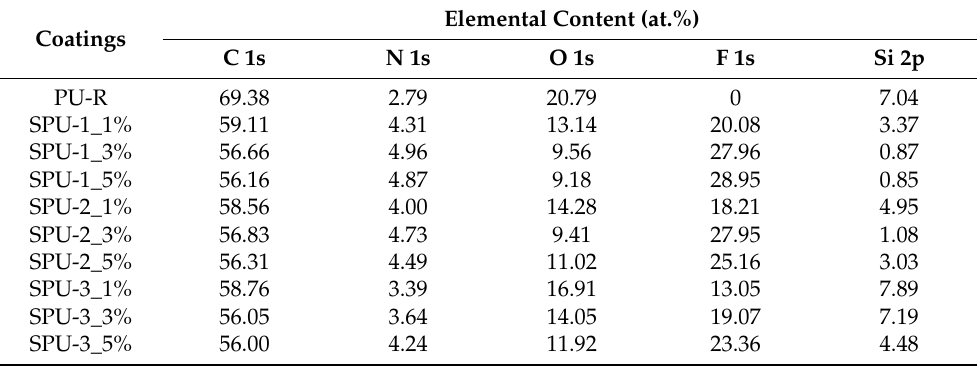
Table 3. XPS analysis of PU-R and SPU